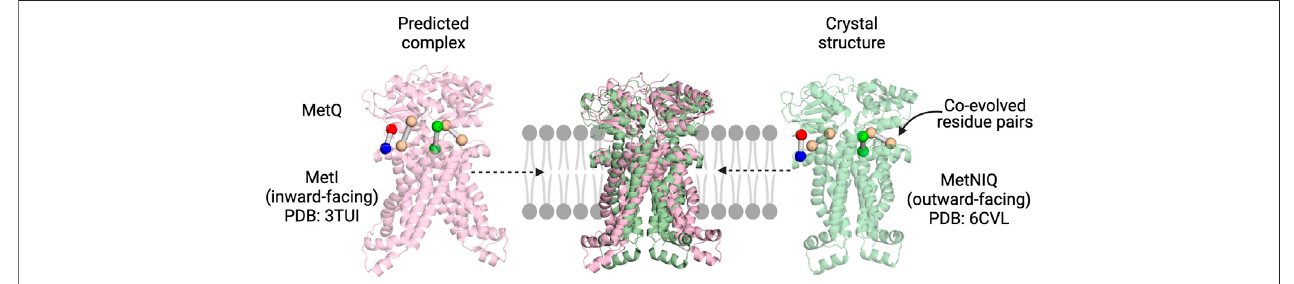
FIGURE 2| Co-evolution analysis as atool to explore SBP:TMD interactions in multicomponent systems. The predicted MetIQ structure (Ovchinnikov et al., 2014) maps well on to the MetNIQ crystal structure (MetN not displayed) (Nguyen et al., 2018). The top co-evolved residues between the two components are in similar positions, with the predicted complex correctly orienting the